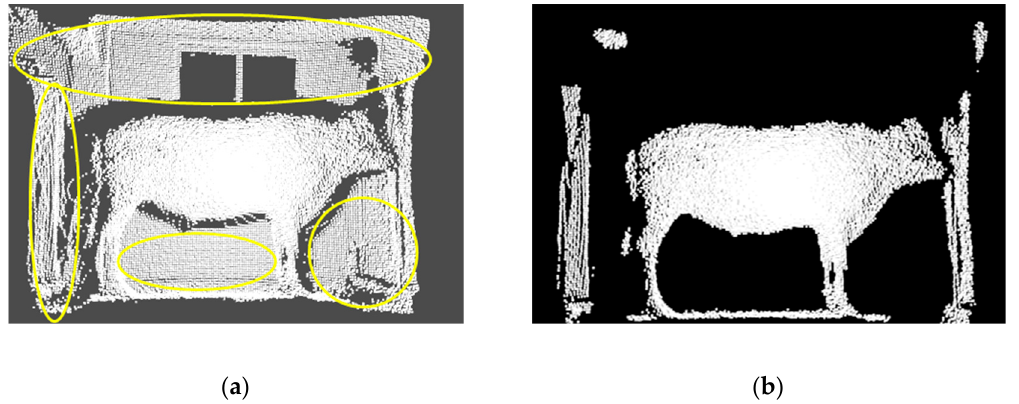
Figure 6. Filtering results with multiple filters. ( a ) Original PCD; ( b ) Results with three filters where most noises and outliers were well removed.